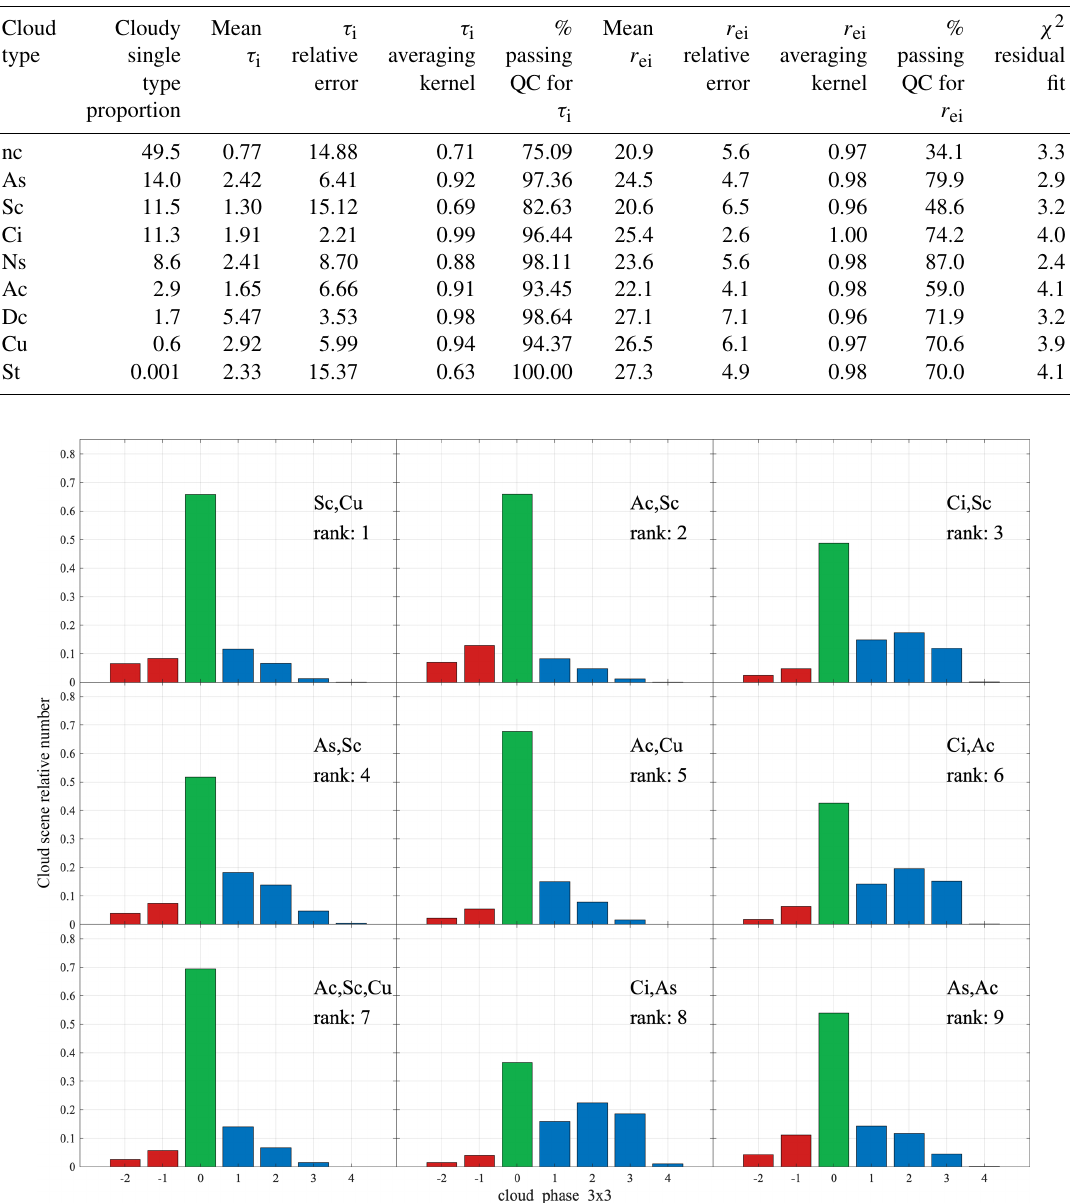
Figure 10. AIRS cloud_phase_3x3 histograms for partly cloudy sky with multiple cloud types for the top nine ranked cloud scenes in order of occurrence